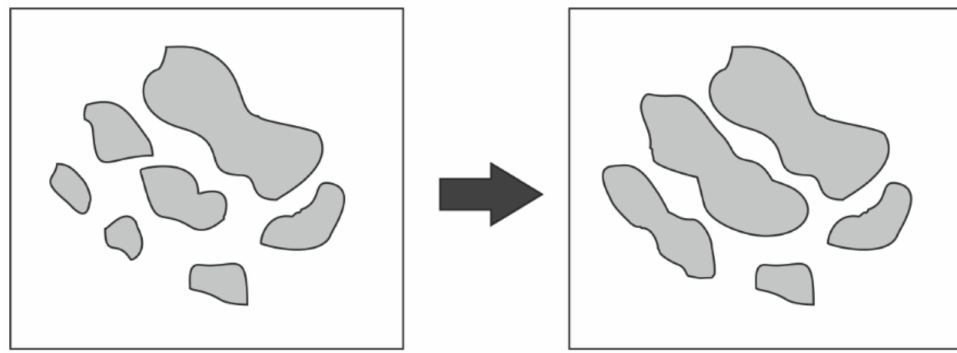
Figure 1. An example of a generalization solution where the similarity of the objects is taken into